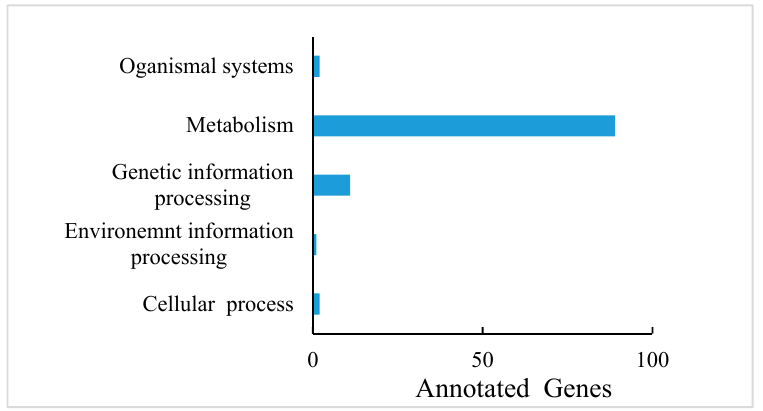
Figure 5. Differentially expressed gene annotations in the KEGG pathway of T. hemsleyanum .